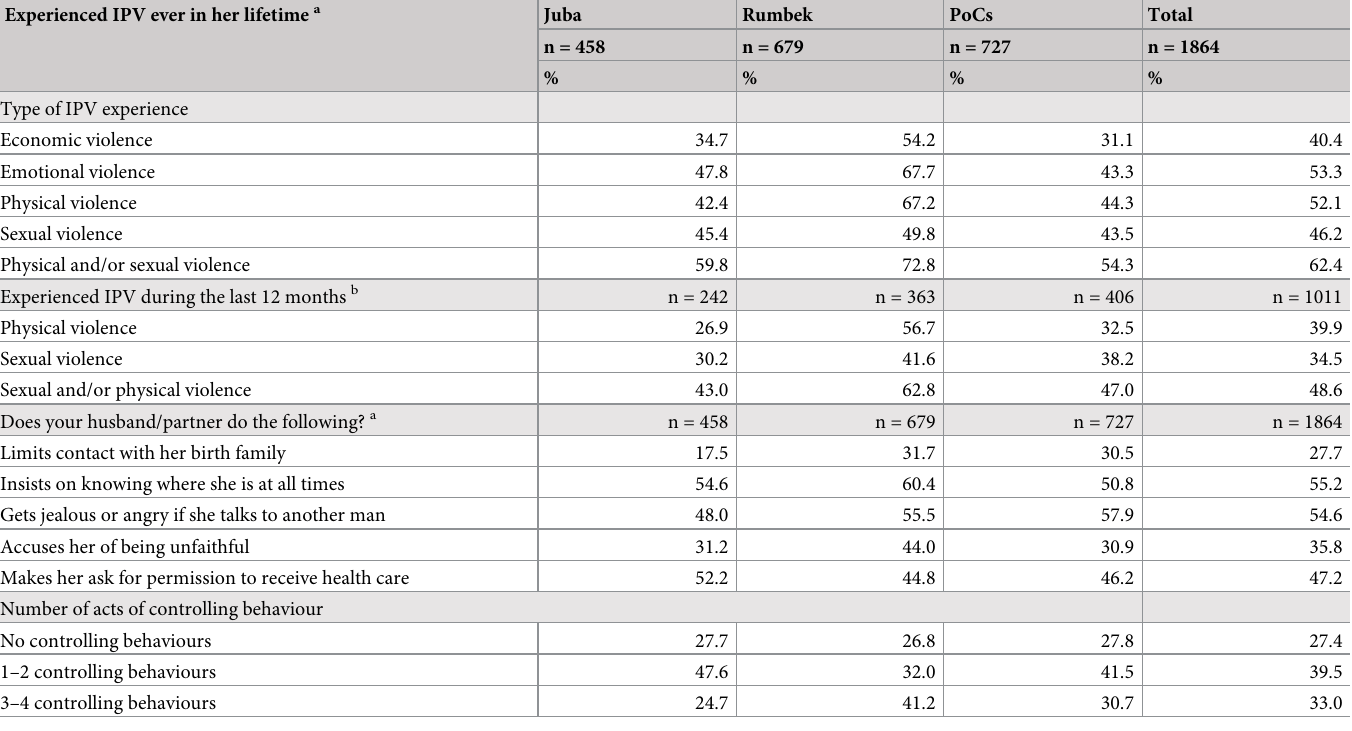
Table 5. Intimate partner violence and controlling behaviours by a